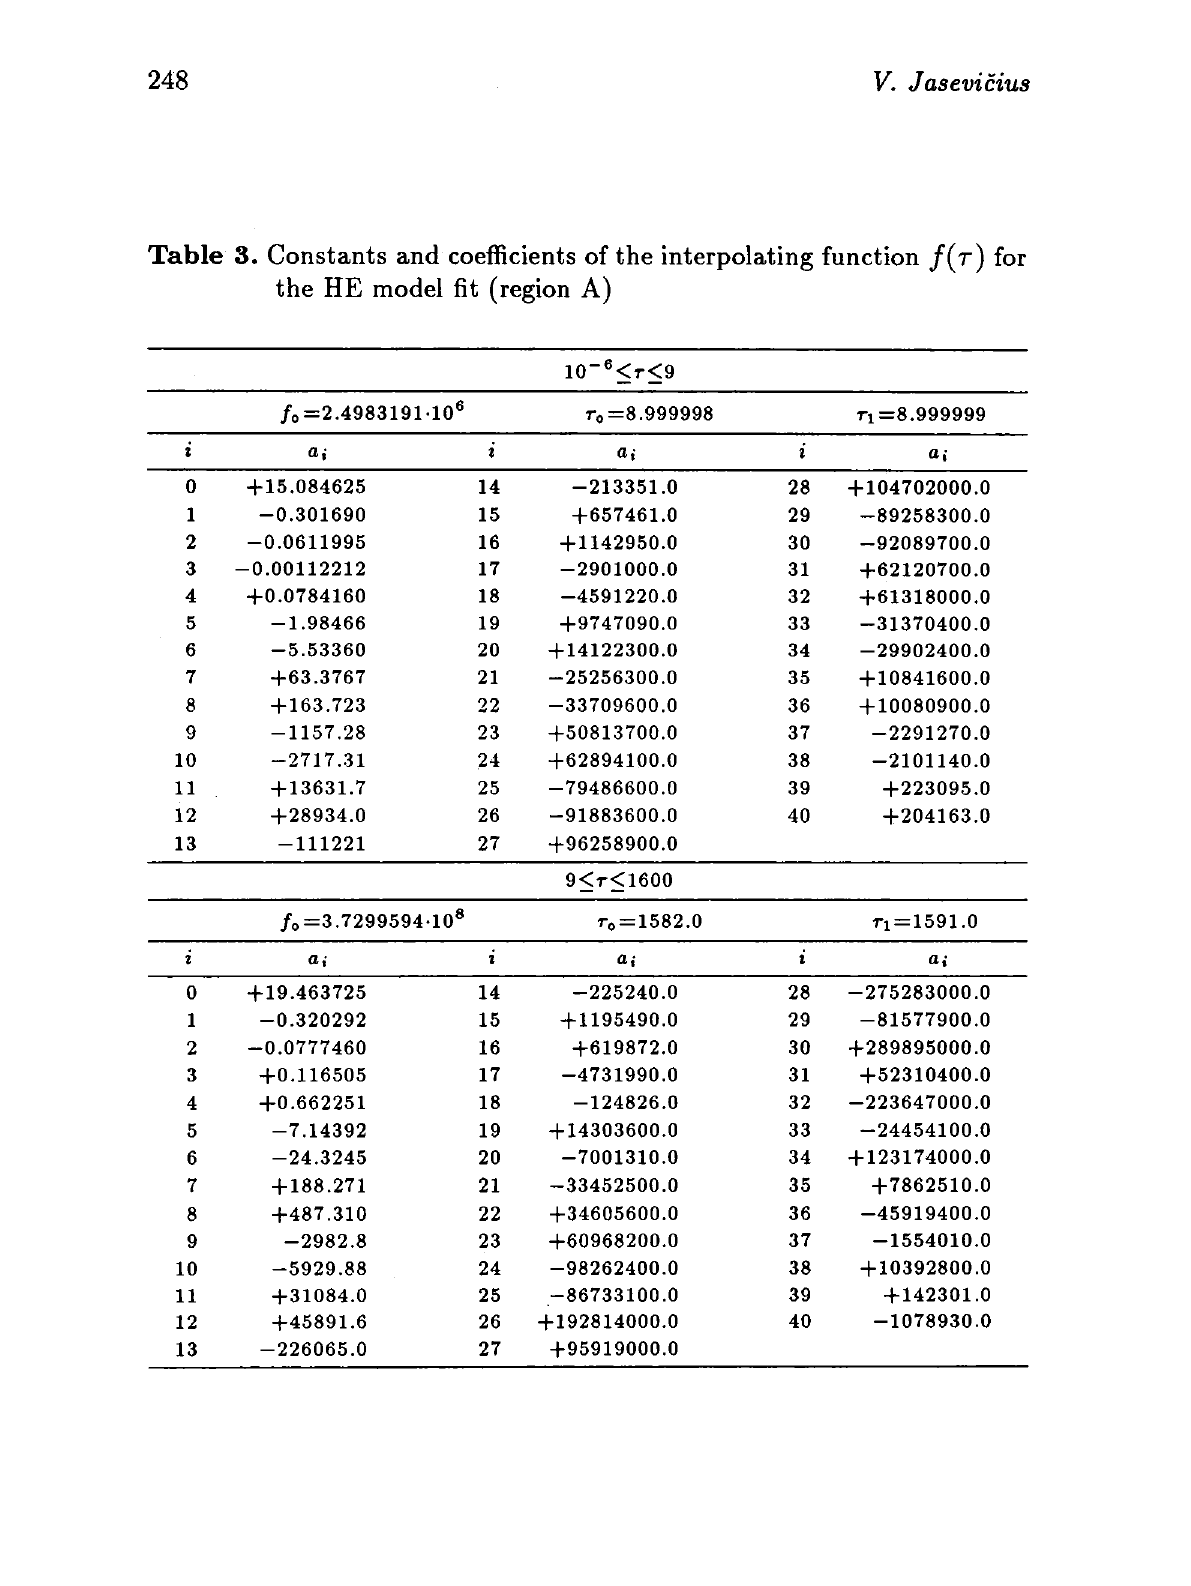
Table 3. Constants and coefficients of the interpolating function / ( r) for the HE model fit (region